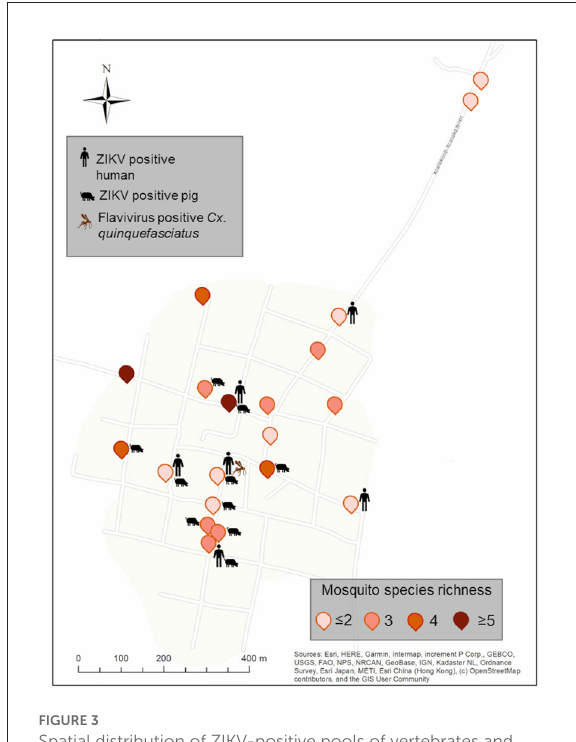
TABLE 4 Zika virus-positive humans in two Mayan communities in Yucatan, Mexico.